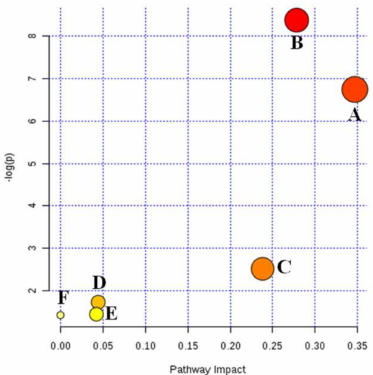
Figure 6. Metabolomics profiling of antithrombotic effect mechanisms on FeCl 3 -induced common carotid arterial thrombosis in rats. (A) arachidonic acid metabolism, (B) sphingolipid metabolism, (C) nicotinate and nicotinamide metabolism, (D) glycerophospholipid metabolism, (E) tryptophan metabolism, and (F) biosynthesis of unsaturated fatty